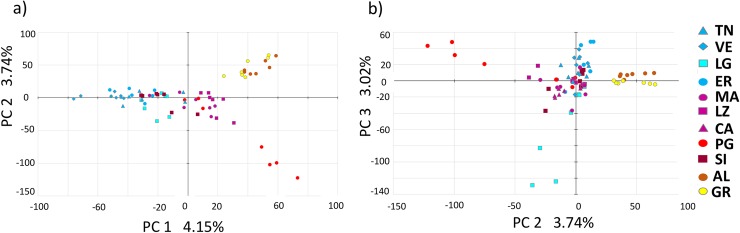
Principal Components Analysis (PCA) presenting the projection of the 2016- dataset (N = 77) on the first two PCs (a) and PCs 2 and 3 in (b). Populations are encoded by different forms and colors according to a north-south gradient for Italy (north-Italy = light-blue, central-Italy = purple, South-Italy = red). Population codes as in Table 1.